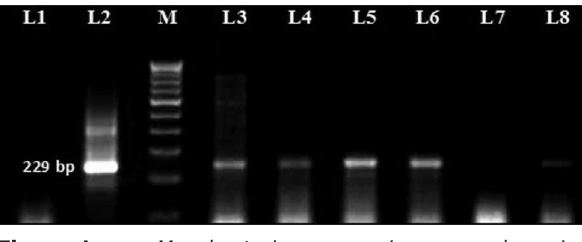
Figure-1: Mycobacterium avium subspecies paratuberculosis -specific amplicons (229 bp) using IS 900 specific primers in goat milk samples. M: Molecular weight DNA marker, 100 bp ladder; Lane 1: Negative control; Lane 2: Positive control; Lane 3,4,5,6 and 8: DNA test samples.